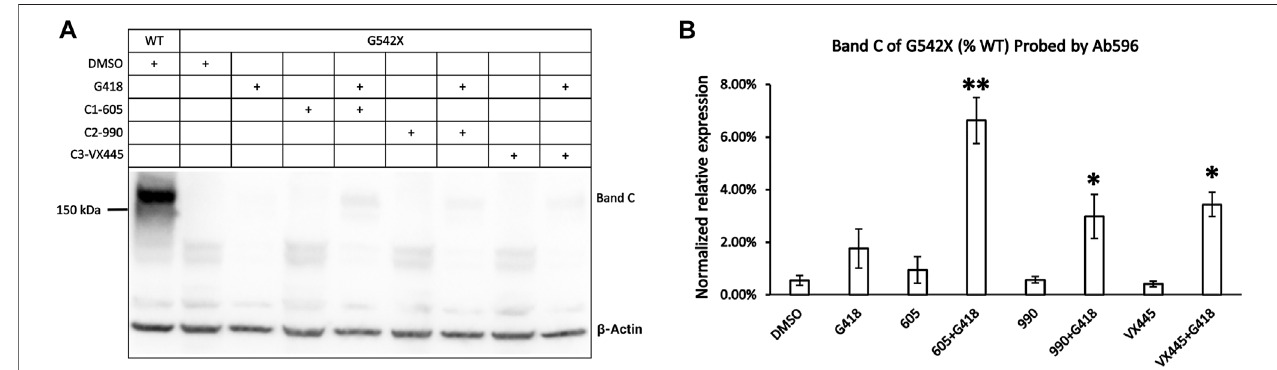
FIGURE 5 | Western blot analysis of the expression of the read-through protein of G542X-CFTR. (A) Effects of type 1 (605), 2 (990), and 3 (VX-445) of CFTR correctorswithorwithouttheread-throughreagentG418onG542X-CFTRexpression.Thegelwasprobedwithantibody596. (B) Quanti fi cationoftheexpressionofthe read-through protein of G542X-CFTR compared to WT-CFTR. The data are represented as mean ± SEM. The asterisks indicated that the expression of the read- through G542X-CFTR protein is signi fi cantly increased by combinations of correctors and the read-through reagent G418 when compared with DMSO (N = 3,